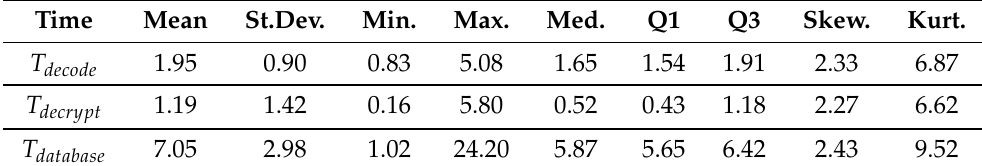
Table 2. Descriptive statistics of the experimental measurement results (miliseconds).